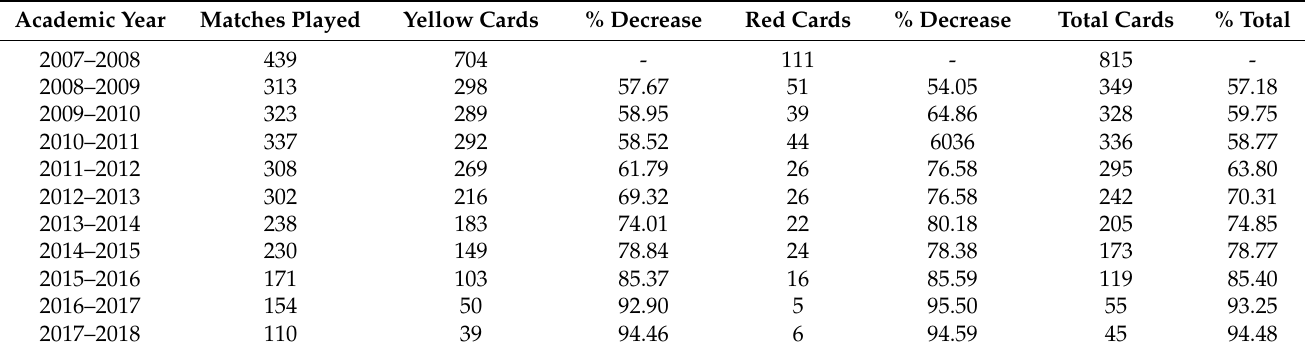
Table 3. Evolution of the number of cards shown in the ten academic years analyzed, and percentage decrease concerning the previous season.